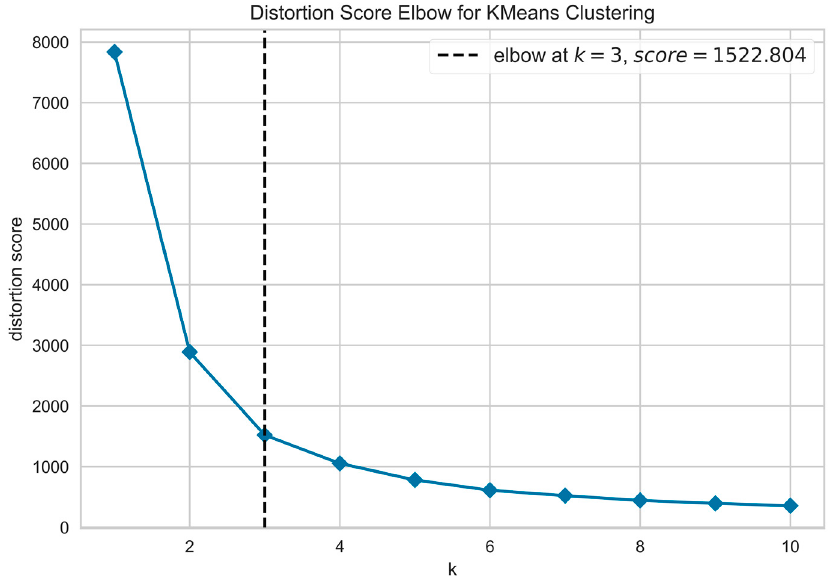
Figure 8. Elbow method estimated by distortion.